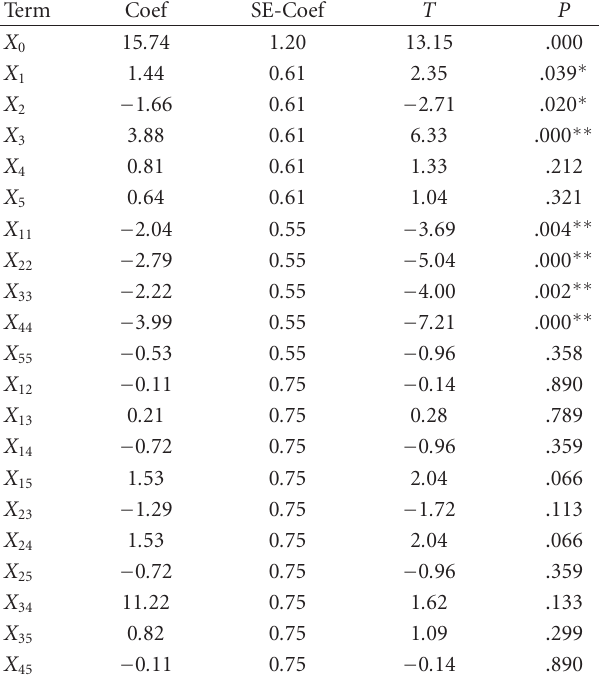
Table 8: Regression results from the data of central composite designed experiments of the optimization of strain Hhs.015 T fermentation conditions.